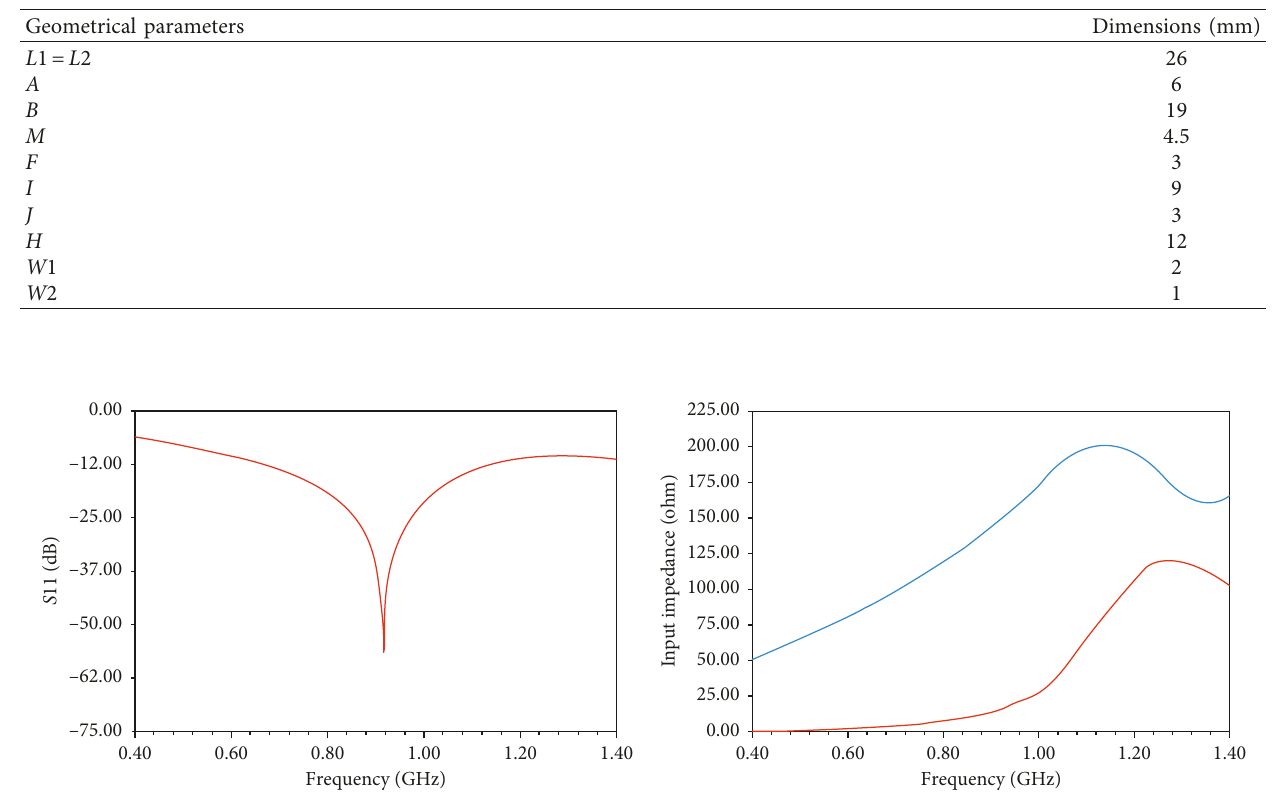
Table 1: Optimal dimensions of the first proposed epidermal RFID antenna.